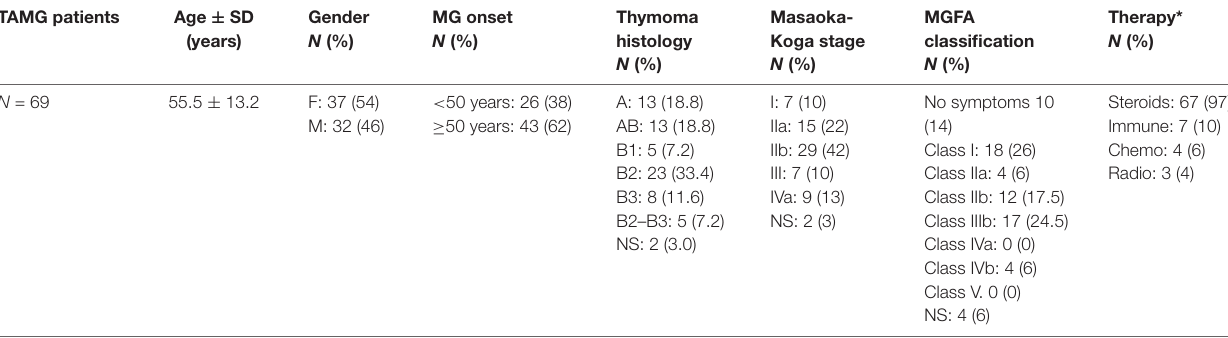
TABLE 1 | Demographic and clinicopathological characteristics of the studied population (adapted from Lopomo et al., 2016). TAMG patients